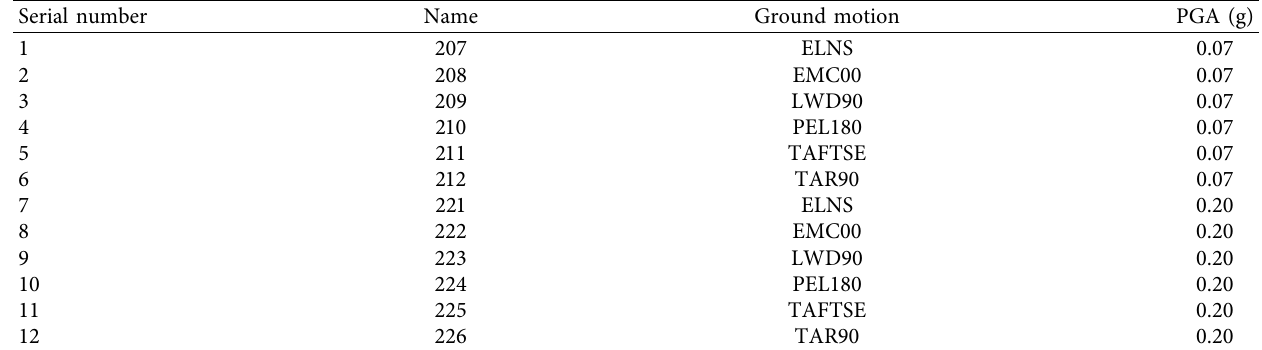
Table 3: Test schedule.